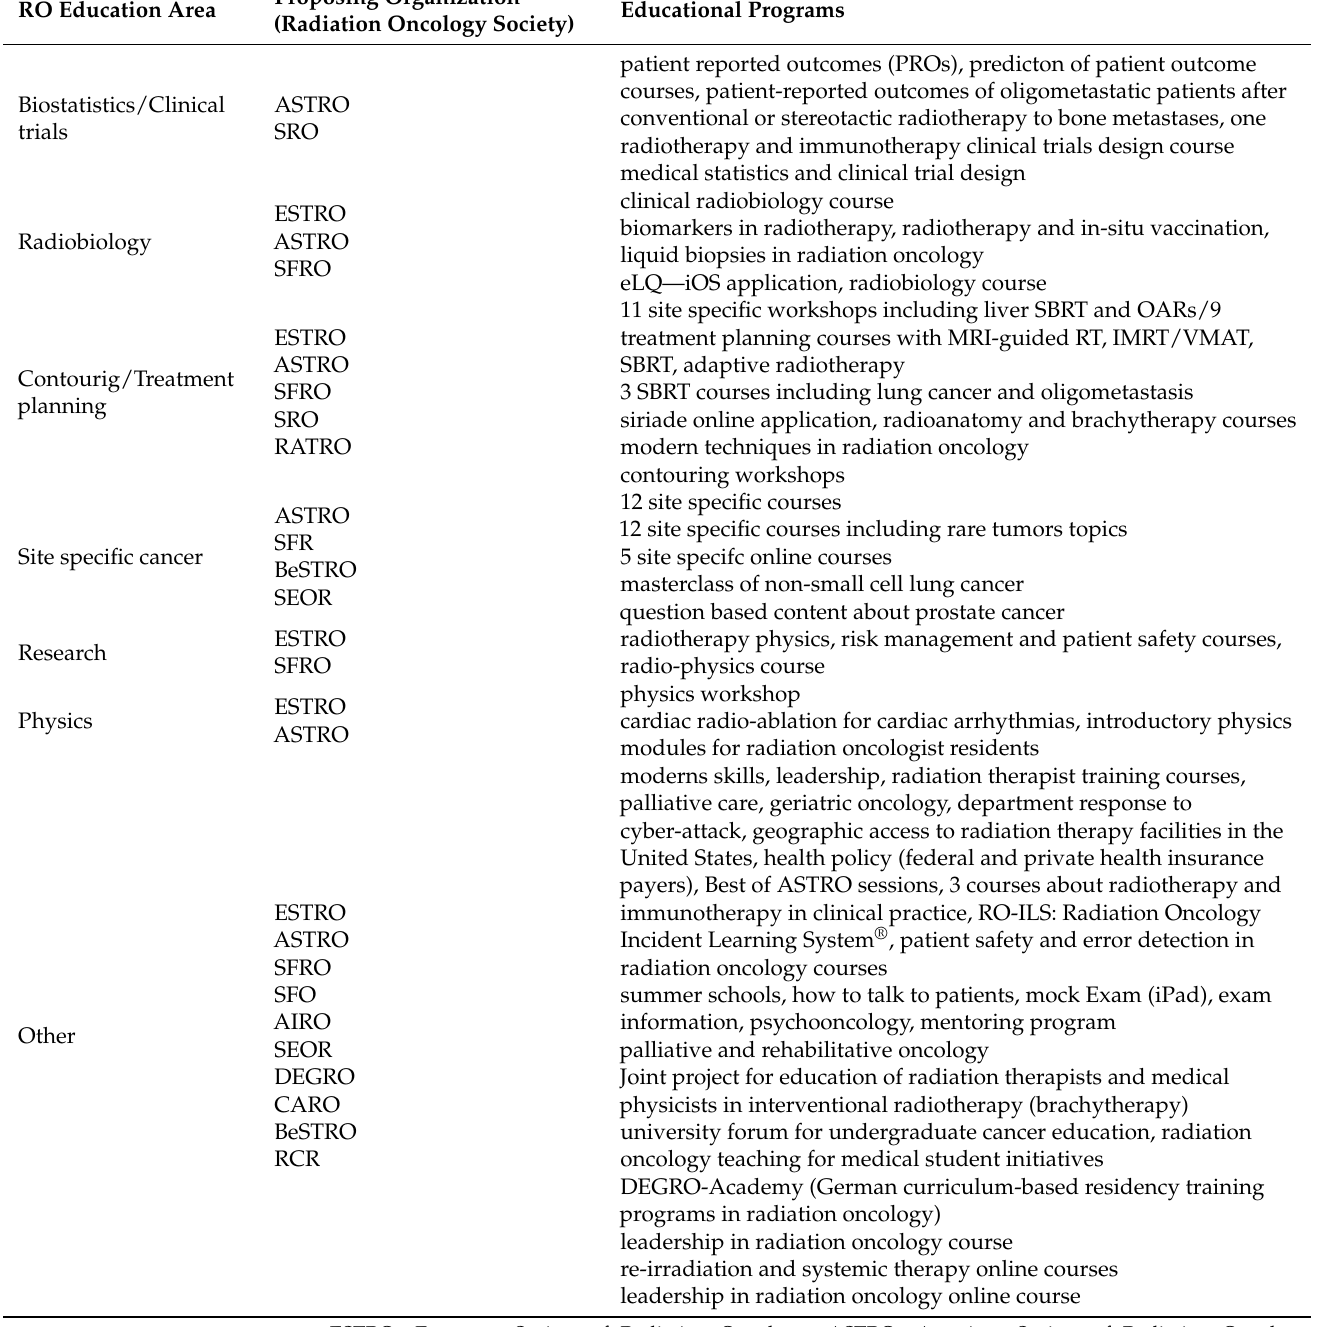
Table 1. Educational initiatives of international and national radiation oncology societies